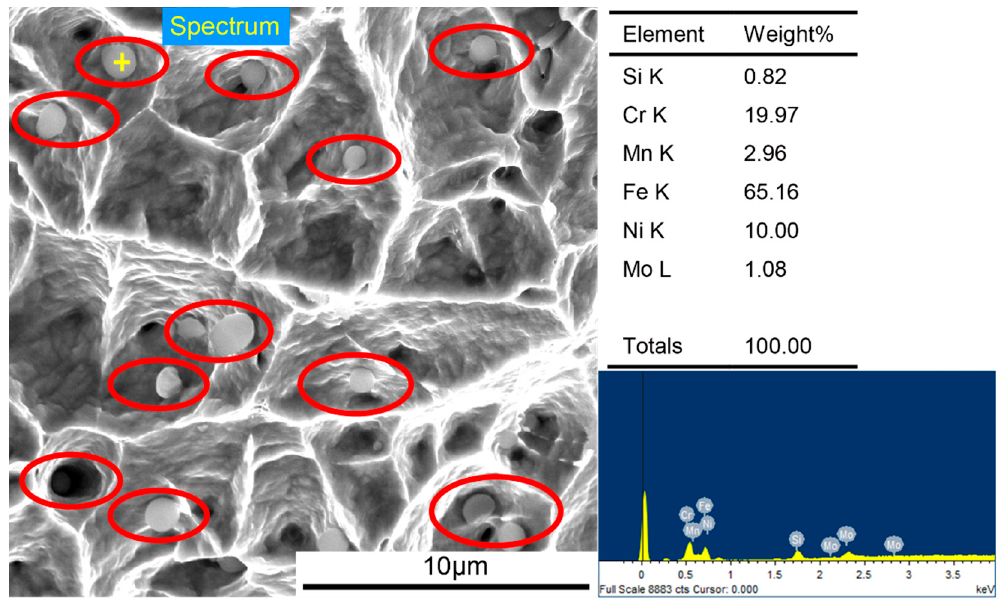
Figure 15. High-resolution electron microscope image of the fracture and EDS analysis of spherical particle on the fracture.